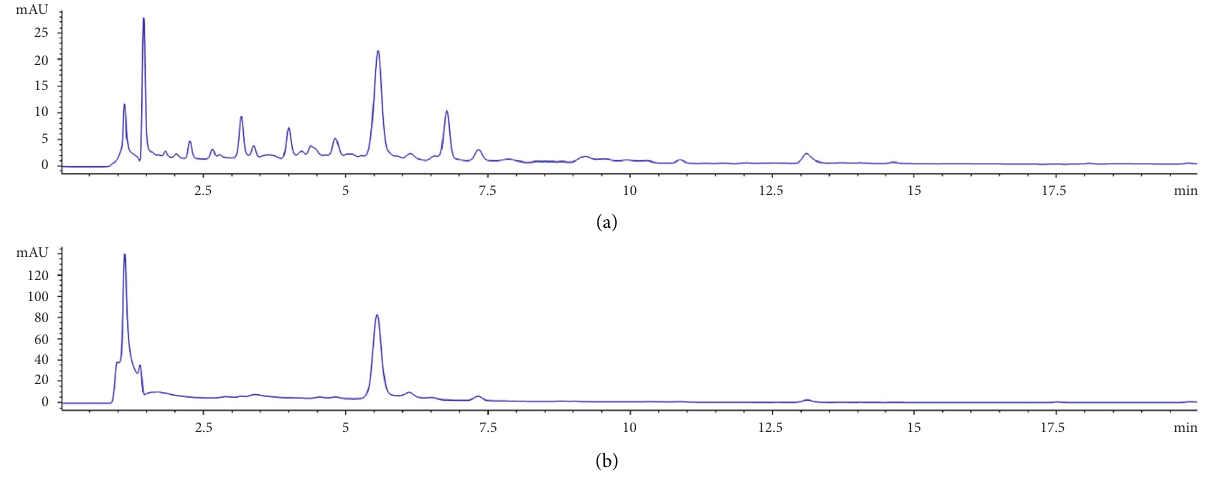
Figure 2: HPLC chromatograms of Gardenia yellow (a) and eluate of macroporous resin columns in-series with optimal conditions (b) at